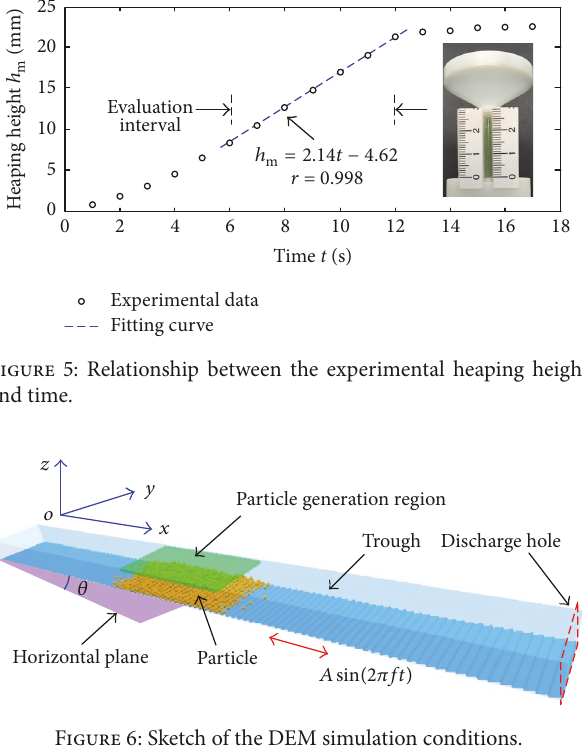
Figure 6: Sketch of the DEM simulation